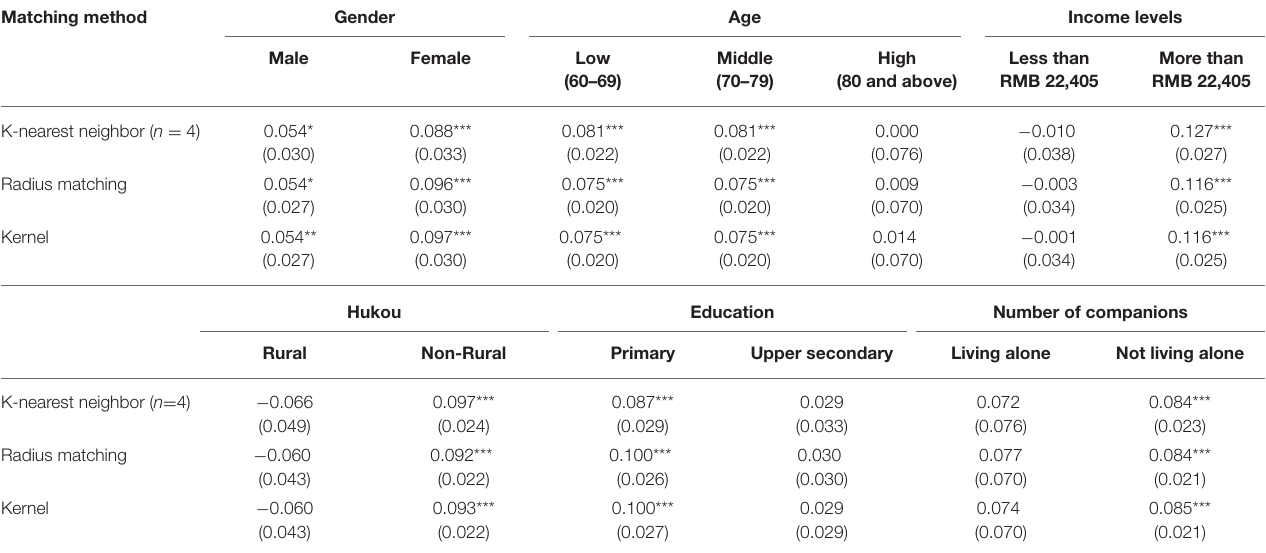
TABLE 9 | Results of heterogeneity analysis (PSM